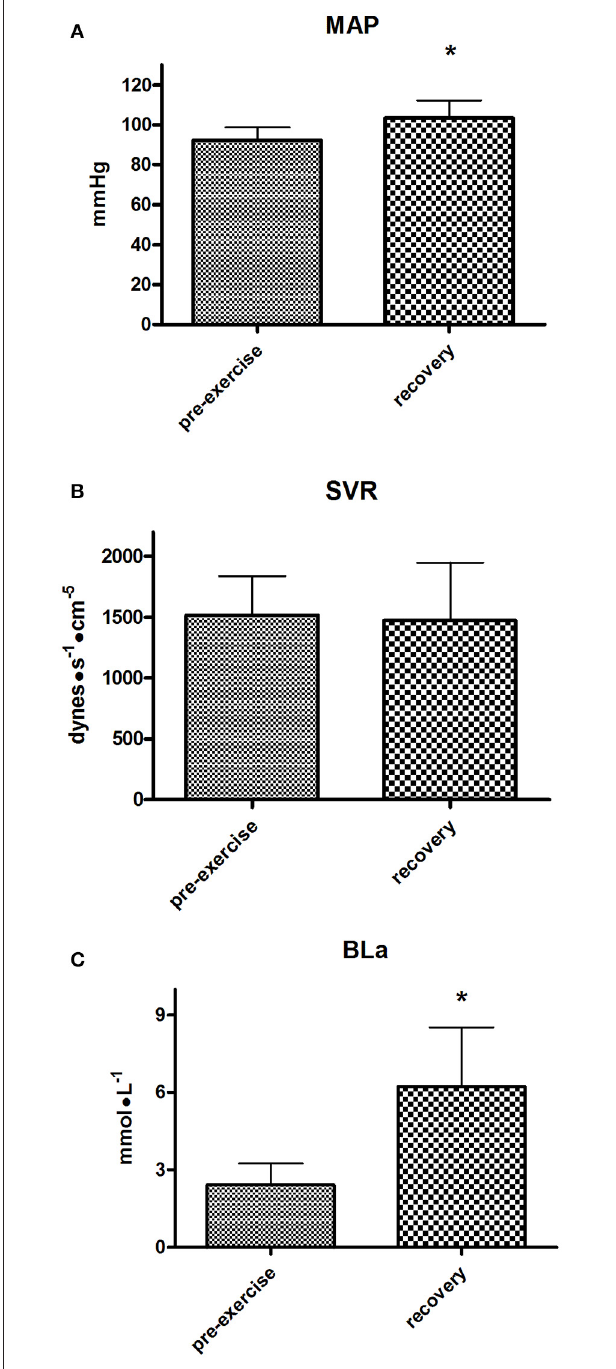
FIGURE 5 | Group mean arterial pressure (MAP, A ), systemic vascular resistance (SVR, B ), and blood lactate (BLa, C ) during the pre-exercise and recovery from the Enduro session. Values are mean ± SD ( n = 15). * p < 0.05 vs.